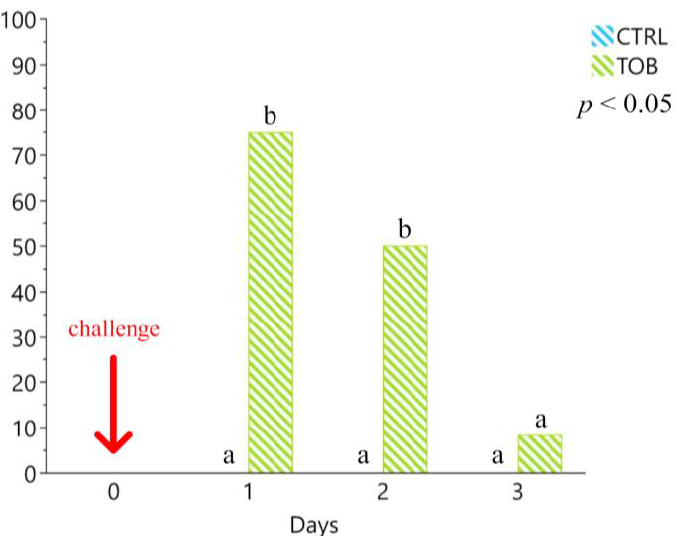
Figure 2. Faecal shedding of the O138 E. coli challenge strain after experimental infection for the challenged control (CT) and the challenged treatment (UT) groups during the first five days post- challenge. The experimental infection was represented by a single intragastric inoculum (5 mL) equivalent to 1 × 10 10 O138 F18 E. coli colony-forming units (CFU)/5 mL and was performed at day 20. The arrow indicates the day of infection. The results are presented as percentages of positive animals per total animals per group for each day. a–b Different lowercase letters indicate statistically significant differences ( p < 0.01). UC: unchallenged control group, UT: unchallenged treatment group, CC: challenged control group, CT: challenged treatment group. The results are presented as a percentage of positive samples per total animals for each